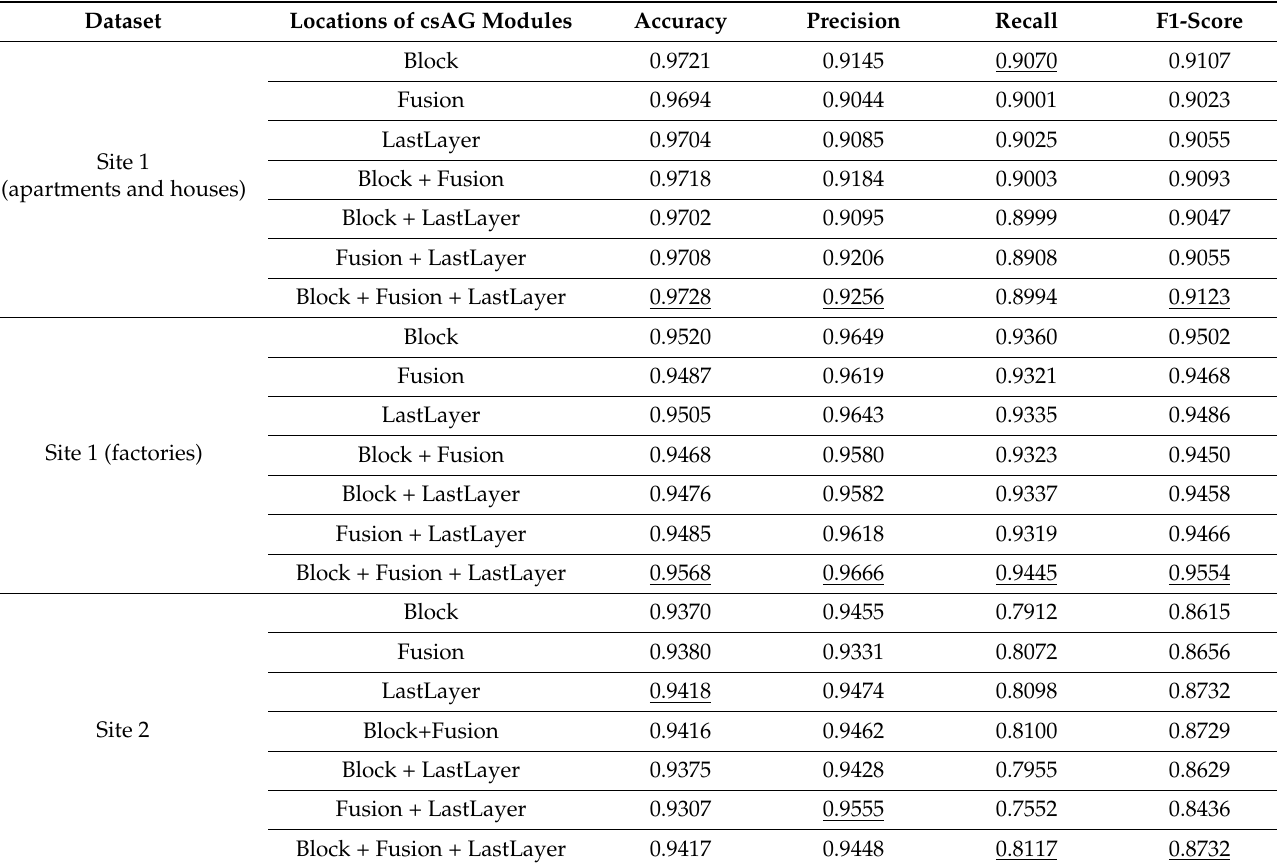
Table 6. Building extraction results depending on the locations of the csAG modules in each process of HRNet-v2.